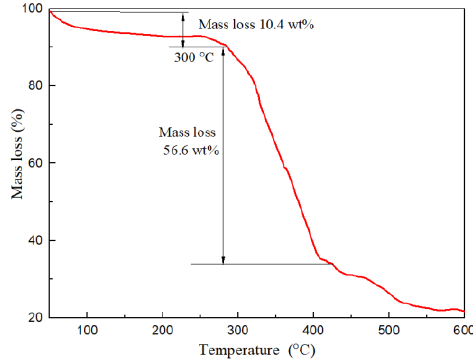
Figure 8. TG curve of VR-H.